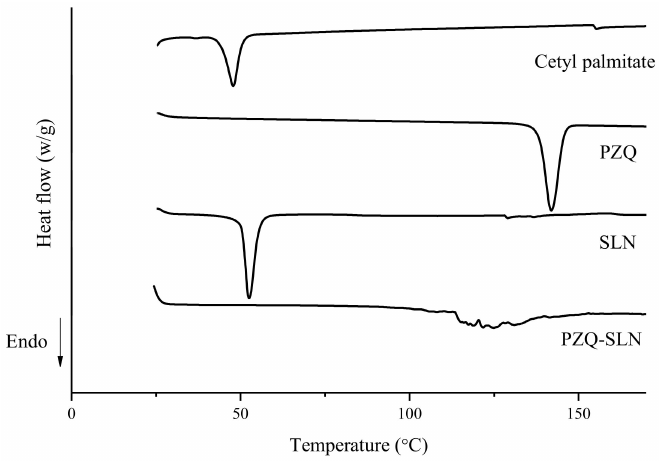
Figure 1. Di ff erential Scanning Calorimetry (DSC) curves of praziquantel solid lipid nanoparticle (PZQ-SLN), SLN, PZQ, and cetyl